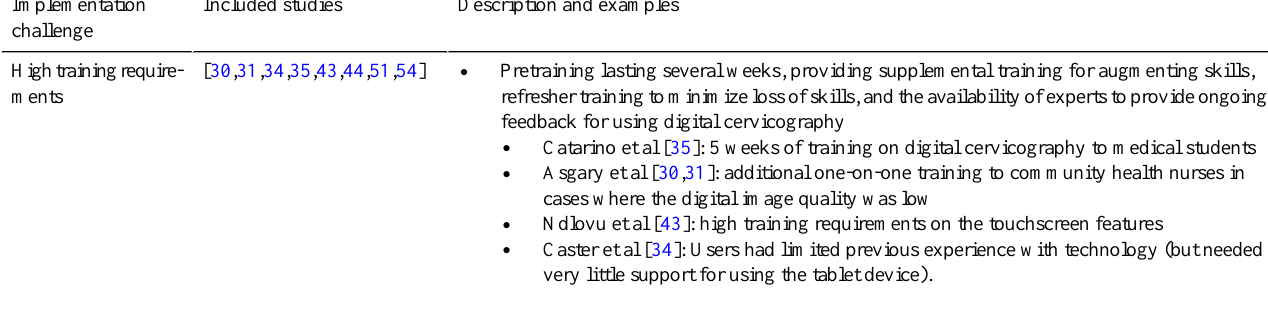
Table 4. Description of implementation challenges for digital health strategies for cervical cancer control.